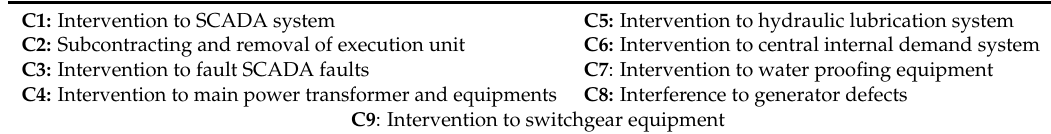
Table 1. Criteria about personnel skills (C1, C2, . . . , C9).